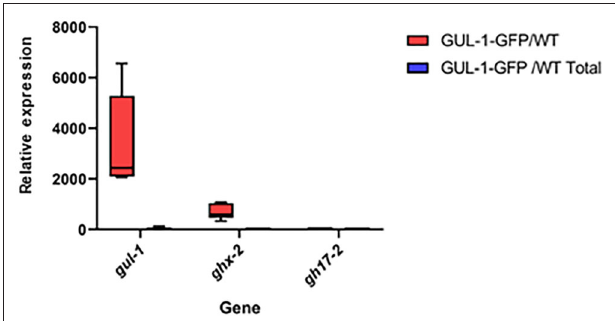
FIGURE 1 | GUL-1 physically interacts with different mRNAs. Relative mRNA abundance of gul-1 , ghx-2, and gh17-2 , as determined by RT PCR, in RNA immunopercipitants obtained from the GUL-1-GFP and the wild-type strains. Bars indicate ± 1.96 SE (confidence level of 95%), as determined on the basis of three independent